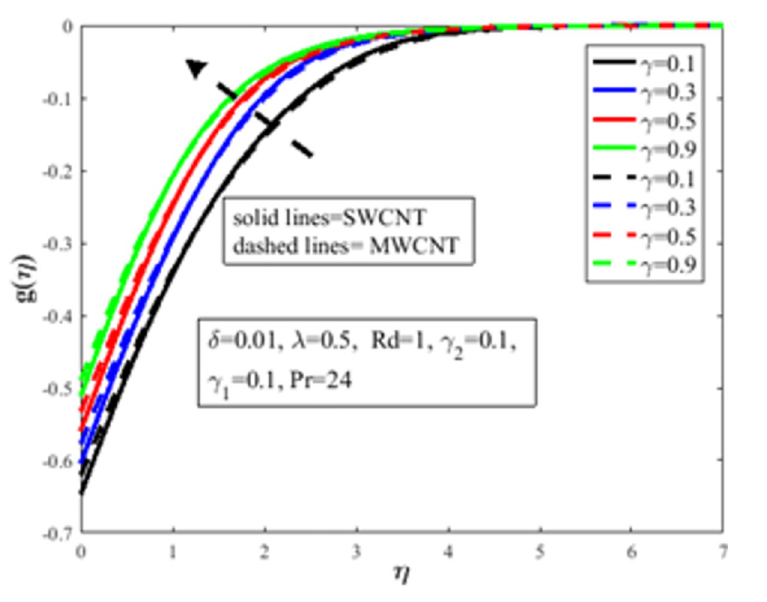
Fig 7. Effect of γ on g ( η ).